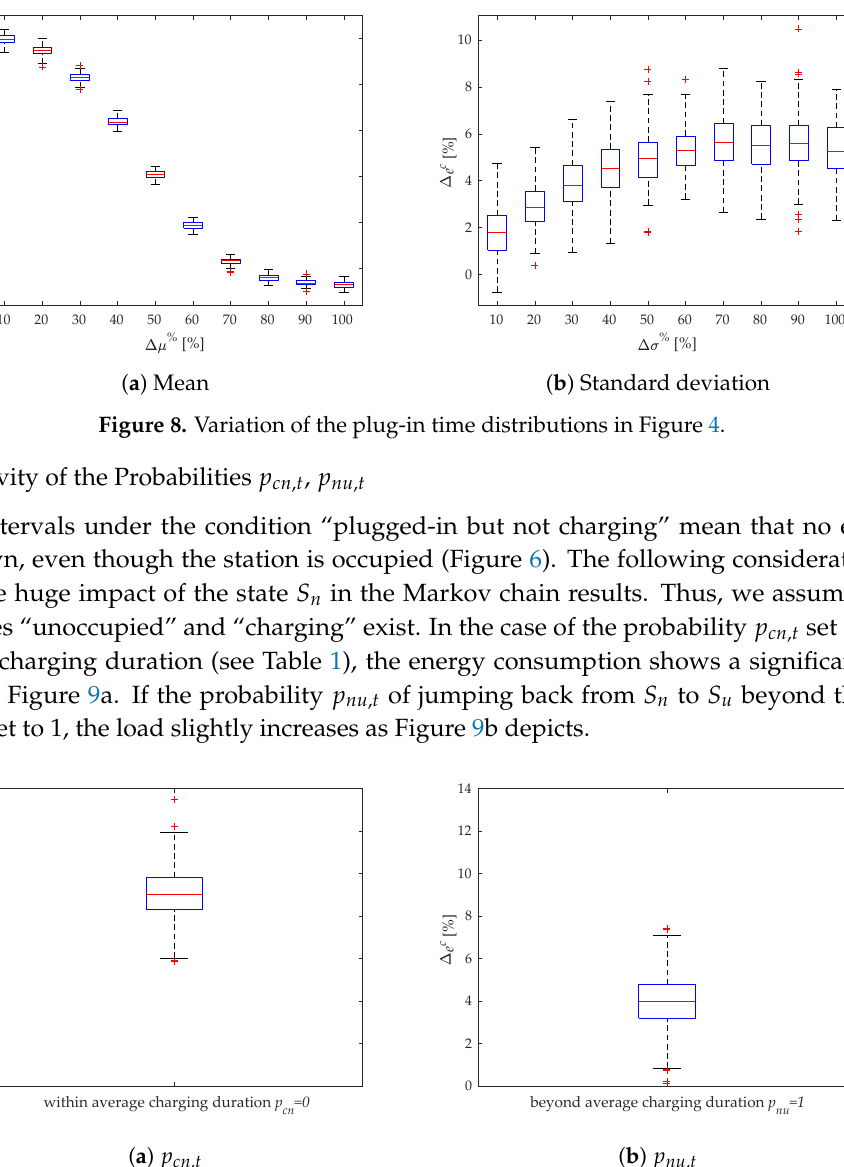
Figure 9. The parameters p cn , t and p nu , t in Table 1 are